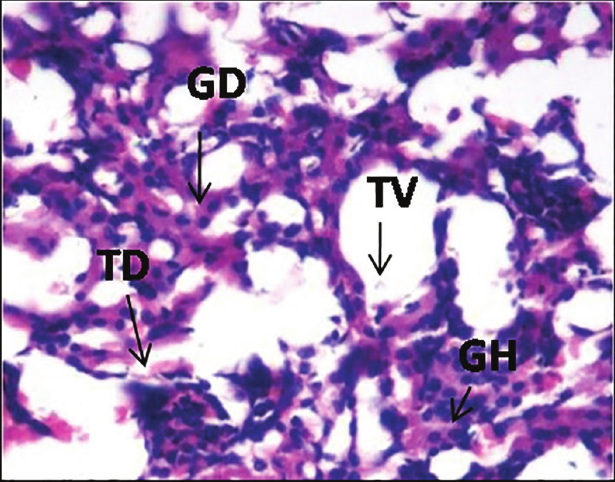
FIGURE 2(D) - Photomicrograph of section of kidney of neonate of pregnant rat exposed to pesticide glyphoshate shows marked degenerative changes (TD) and vacuolization within tubules (TV). Some glomeruli appear hypercellular (GH) and some show degeneration and shrinkage (GD). Focal lymphocytic infiltration noted in the interstitium. (H & E 400